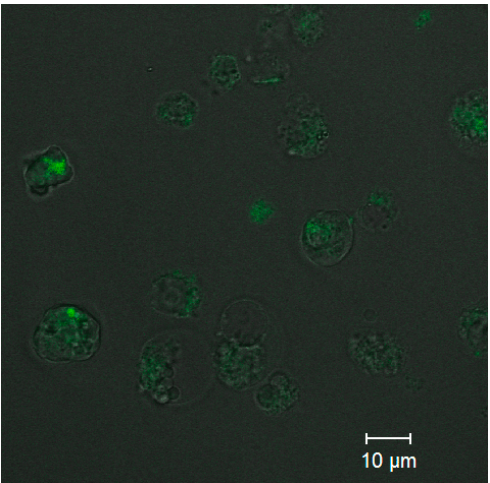
Figure 6. Confocal fluorescence microscopy images of the QDs in